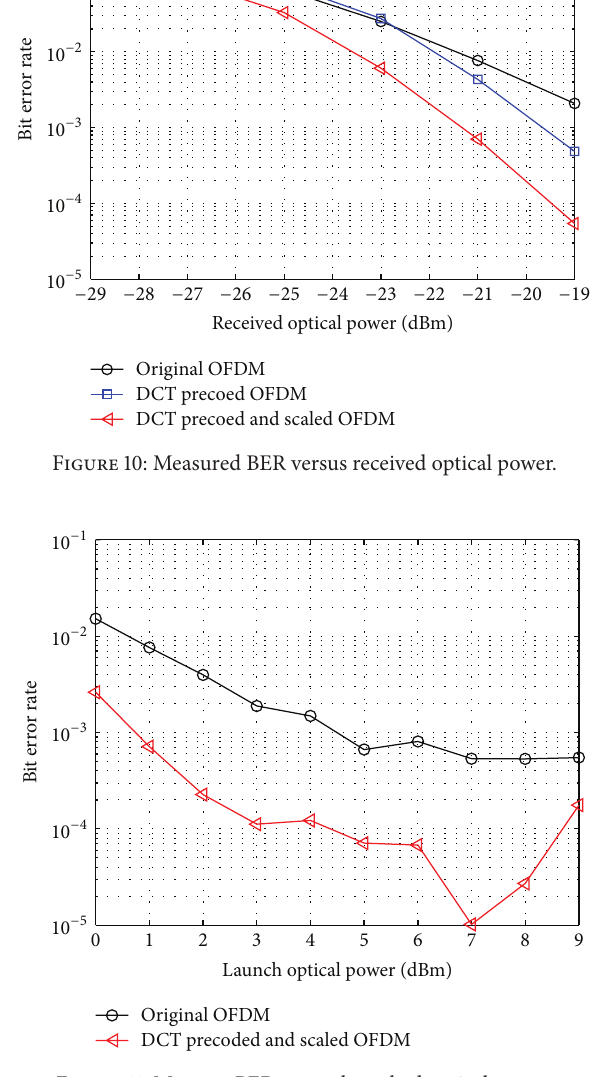
Figure 11: Measure BER versus launched optical